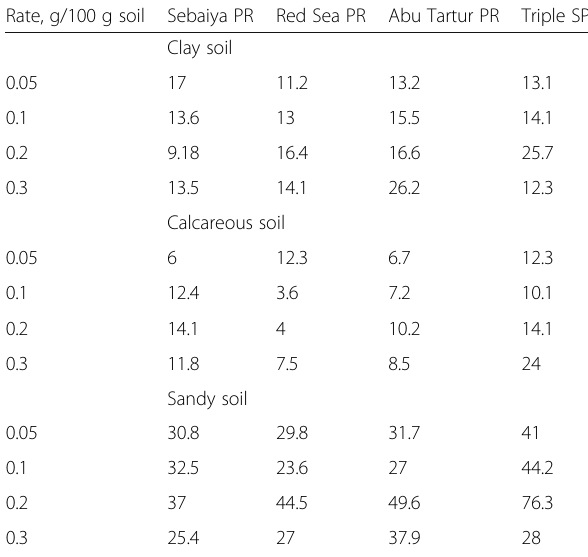
Table 5 Effect of PR rates on P solubilization efficiency after four weeks